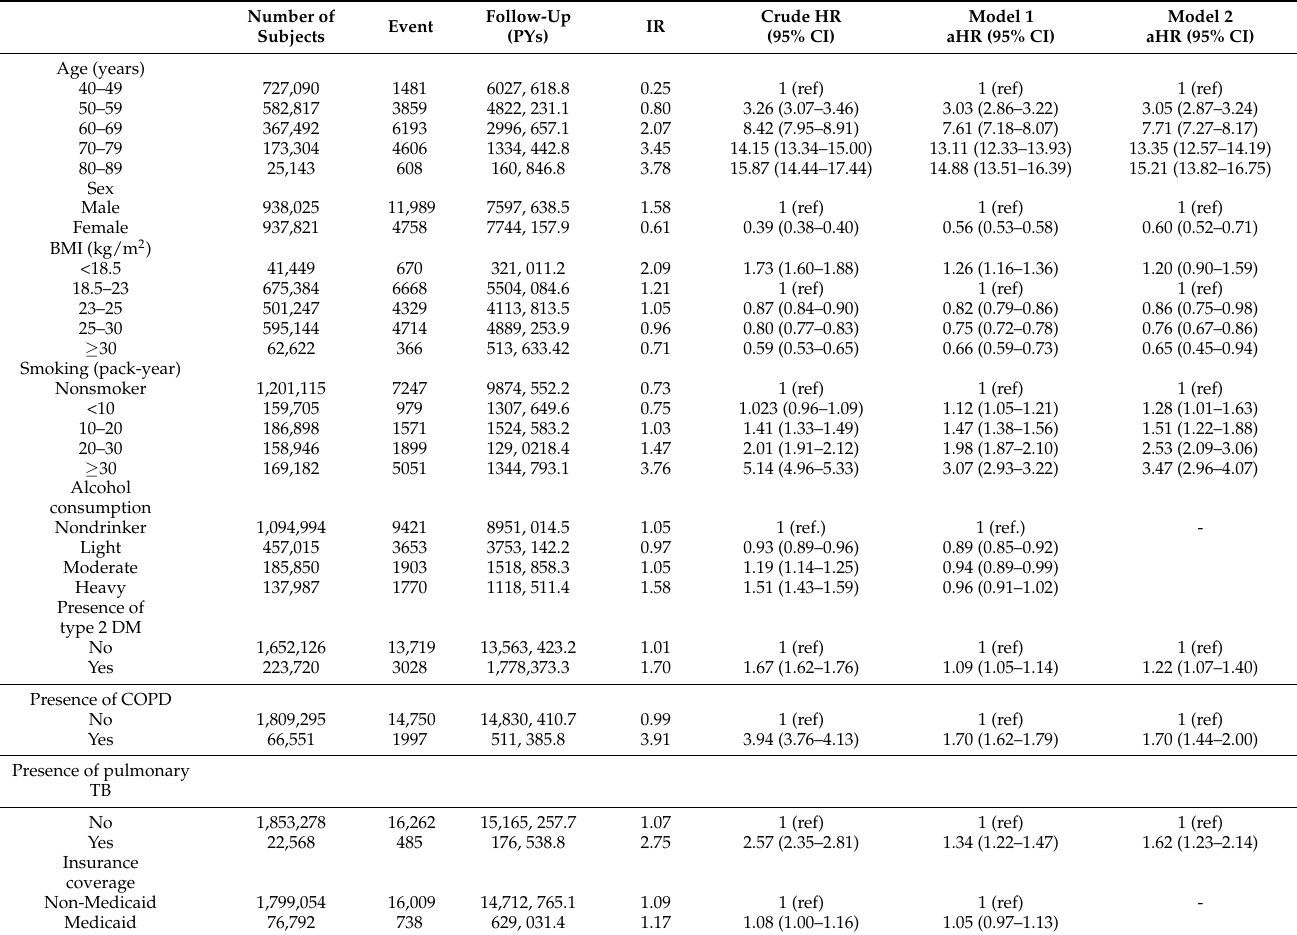
Table 2. Hazard ratios (HRs) and 95% confidence interval (CI) for lung cancer incidence.